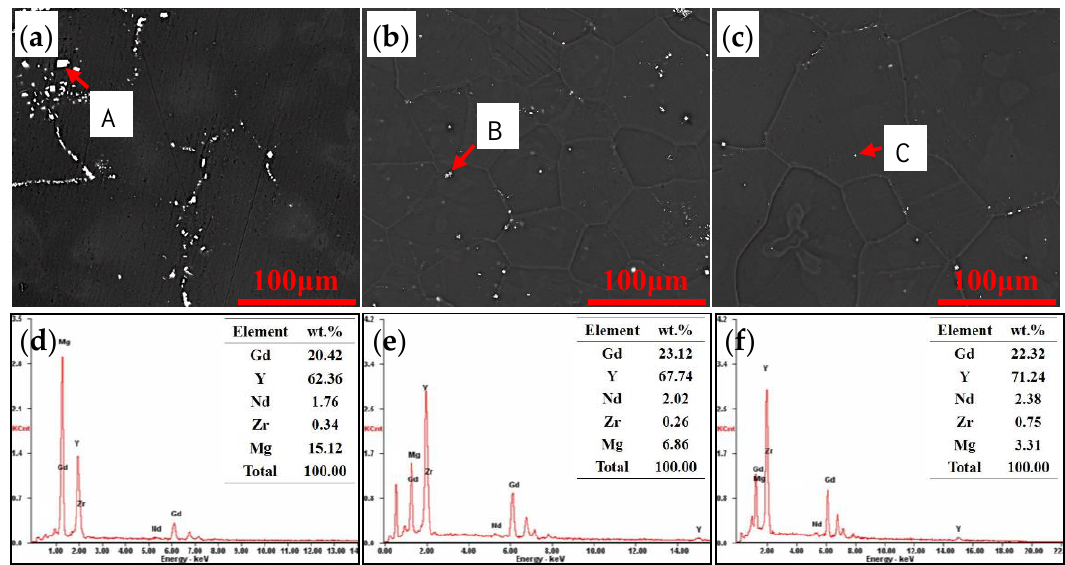
Figure 5. SEM images and EDS results of the solution treated samples: ( a ) SEM image of alloy A, ( b ) SEM image of alloy B, ( c ) SEM image of alloy C, ( d ) EDS results of particle A, ( e ) EDS results of particle B, ( f ) EDS results of particle C.